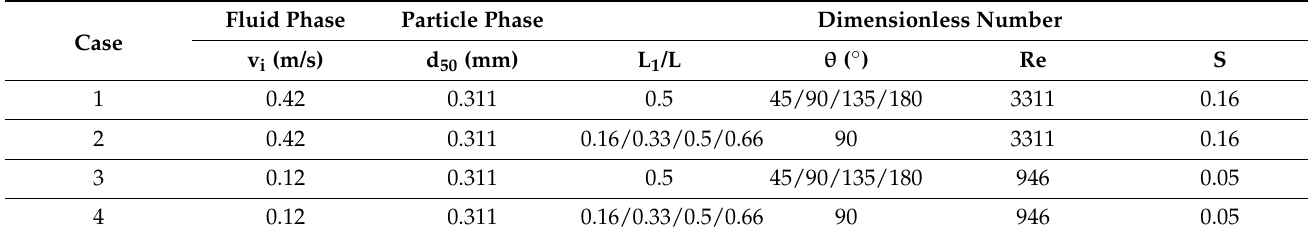
Table 2. Experimental parameters and dimensionless